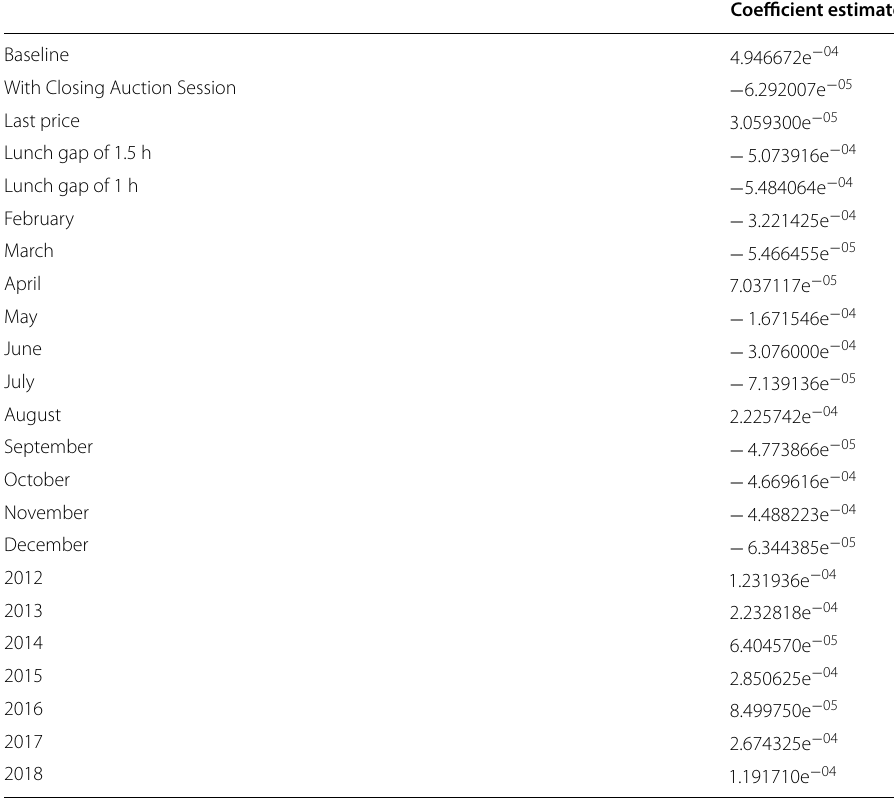
Table 4 Results for the ANOVA model